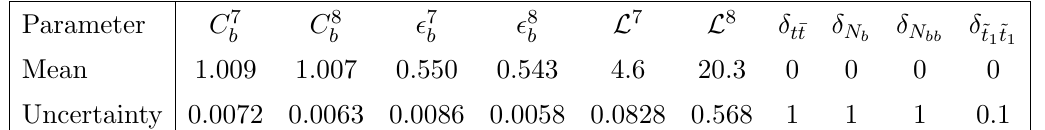
Table 2 . Nuisance parameters used in our recast. The values of C 7 ; 8 uncertainties are taken from the ATLAS analysis [16]. Each parameter is chosen from a Gaussian centered at the mean with a width given by the uncertainty. The luminosity and all other parameters are